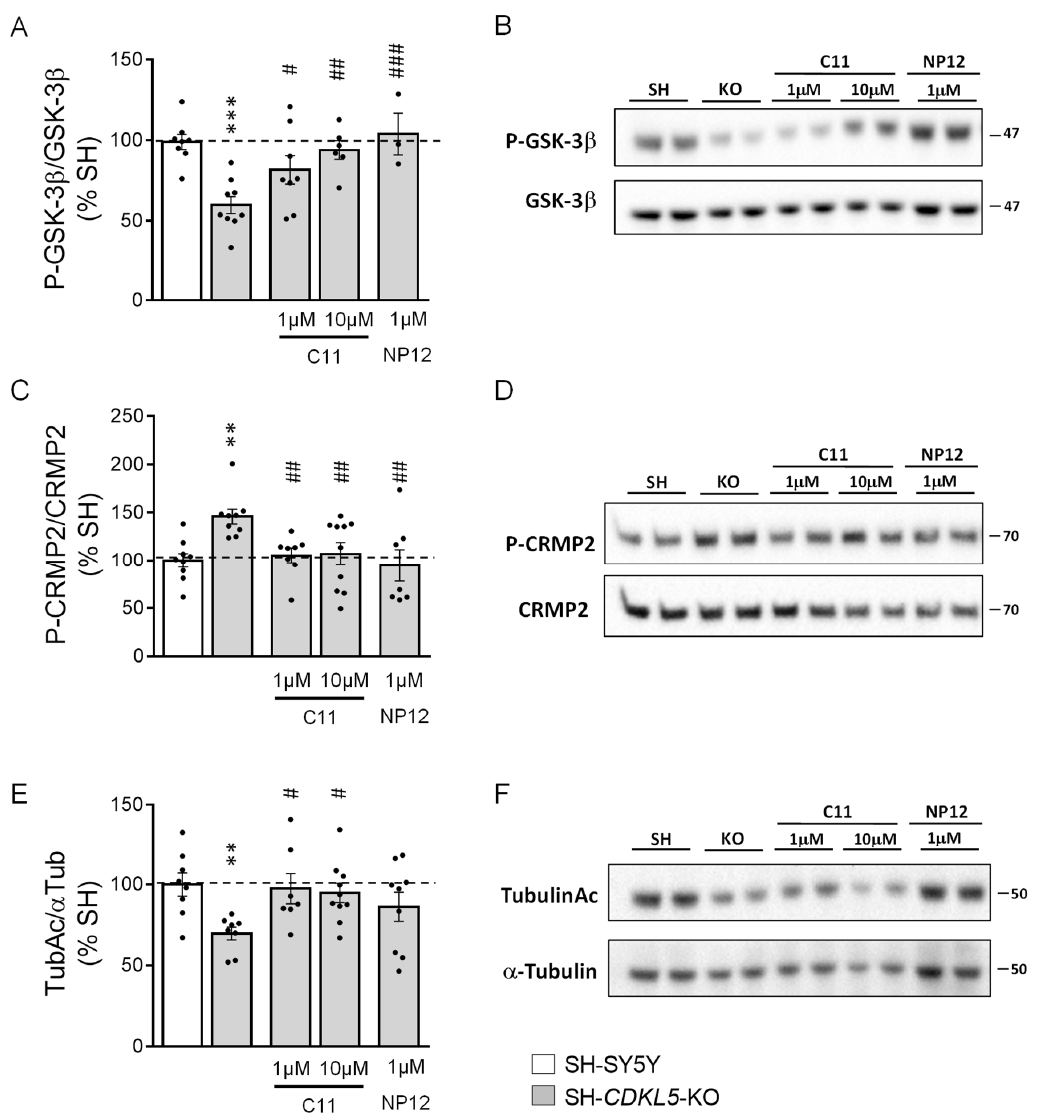
Figure 1. Effect of treatment with C11 on GSK-3 β and HDAC6 signaling in SH- CDKL5 -KO cells. Western blot analysis of phospho-GSK-3 β (Ser9; P-GSK-3 β ; A,B ), P-collapsin response mediator protein 2-(Thr514P; P-CRMP2; C,D ) and acetylated alpha tubulin (TubulinAc; E,F ) levels in protein extracts from parental cells (SH-SY5Y; n = 8–9), SH- CDKL5 -KO cells (SH- CDKL5 -KO; n = 8–9) and SH- CDKL5 -KO cells treated with C11 (1 μ M and 10 μ M; n = 6–9) or NP12 (1 μ M; n = 3–8) for 24 h. Immunoblots are examples from two biological replicates of each experimental condition. Histograms on the left show P-GSK-3 β , P-CRMP2, and TubulinAc protein levels normalized to corresponding total protein levels. Data are expressed as a percentage of parental cells. Values are represented as means ± SE. ** p < 0.01; *** p < 0.001 as compared to the vehicle-treated SH-SY5Y condition; # p < 0.05; ## p < 0.01; ### p < 0.001 as compared to the vehicle-treated SH- CDKL5 -KO condition (Fisher’s LSD test after one-way